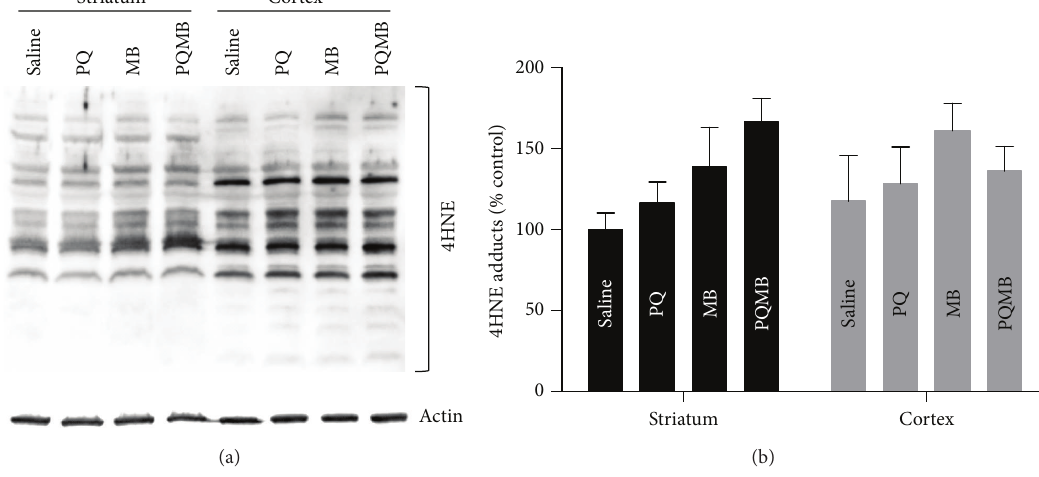
Figure 3: Extracts of striatum and cortex display distinct patterns and intensity of 4HNE protein adducts. Extracts ( 𝑁 = 3 ) were immunoblotted using an antibody specific for 4HNE-modified protein (a). Quantification of 4HNE-modified proteins shows treatment- related changes in striatal HNE adducts (b). Western blots were conducted in